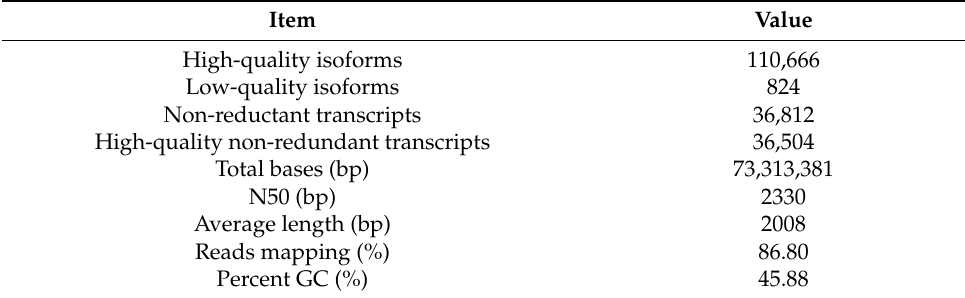
Table 1. Summary of the transcriptome of P. polyphylla var. yunnanensis .